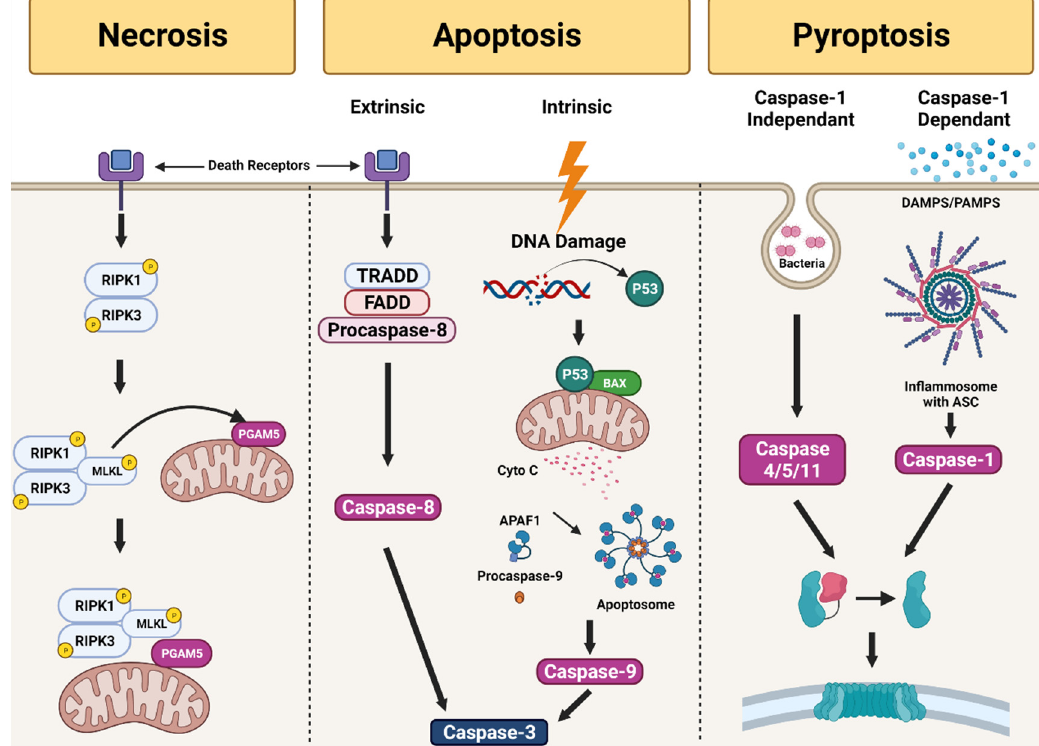
Figure 2. Overview of necrosis, apoptosis, and pyroptosis pathways involved in retinal pigment epithelium (RPE) cell death in age-related macular degeneration. In necrosis, the necrosome forms complex proteins that attach to the mitochondrial membrane, triggering cell death. Apoptosis can be activated through the intrinsic or extrinsic pathways, which eventually result in the activation of caspase 3 and then cell death. Pyroptosis can occur through caspase 1-dependent or independent pathways, which lead to the generation of an N-terminal fragment that induces cell death.